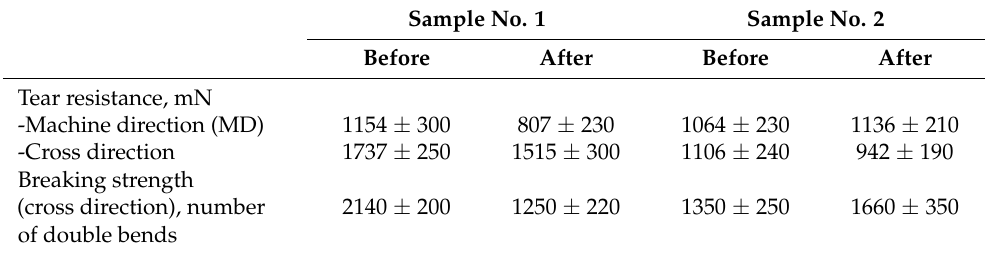
Table 2. Strength properties for paper sample nos. 1 and 2 before and after modification. Sample No. 1